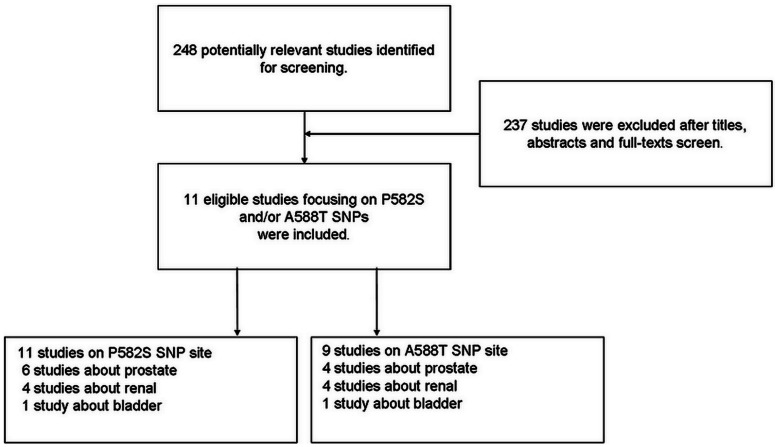
The flow diagram of search strategy in this meta-analysis.